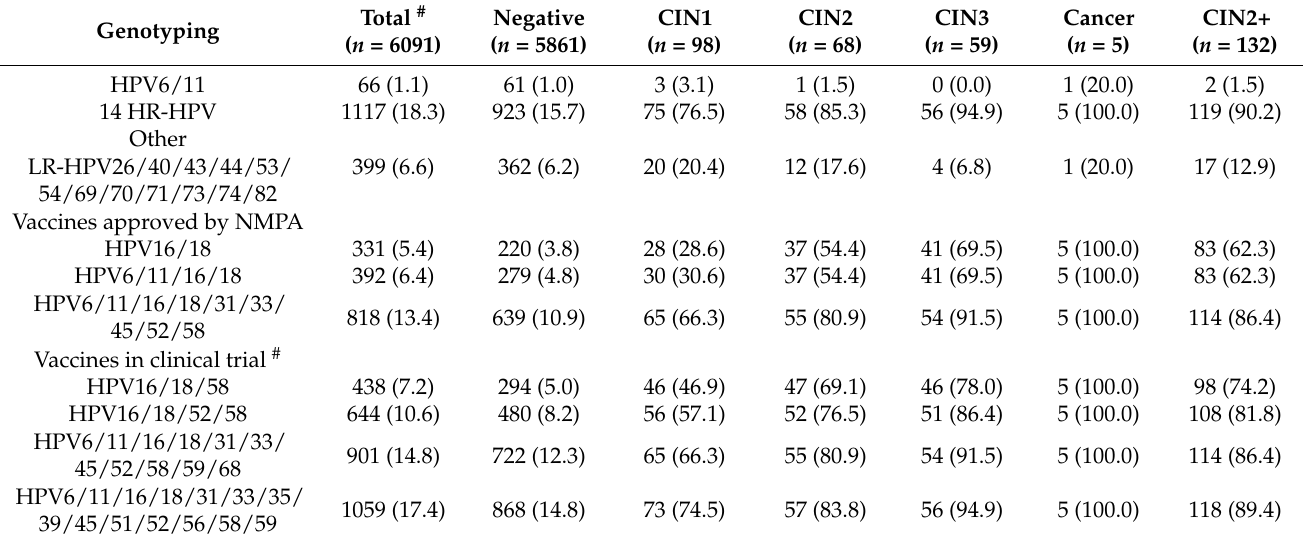
Table 5. The prevalence of different HPV types combination in 6286 women, China, stratified by pathology n